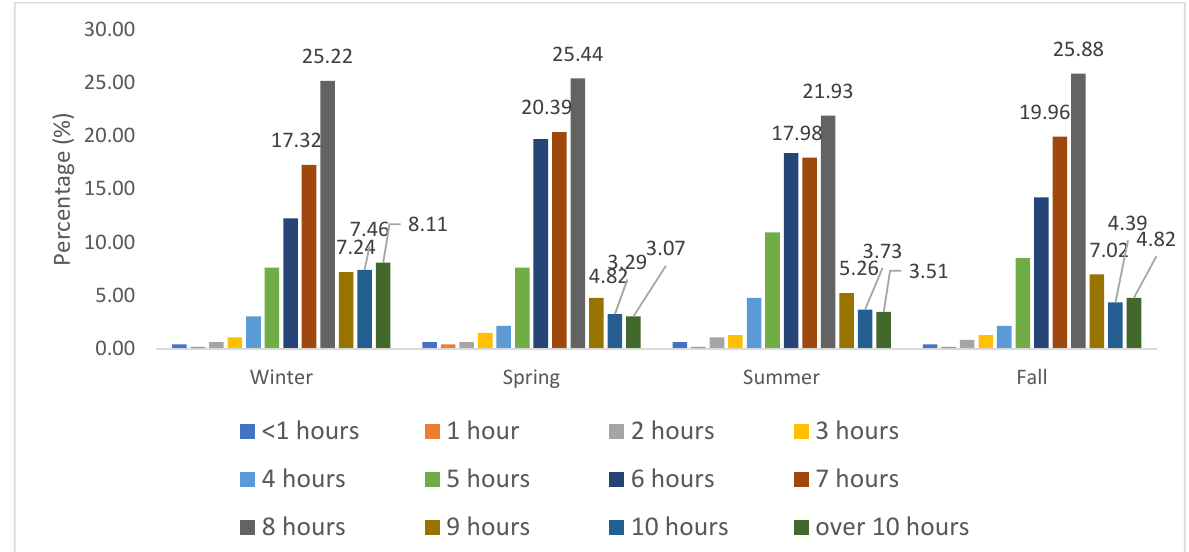
Figure 3. Hours of sleep during the four seasons.